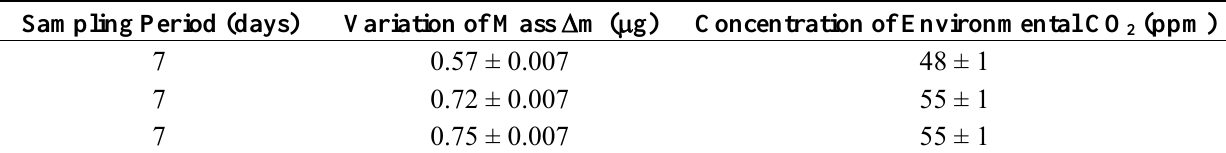
Table 1. Variation of mass in relation to the quantity of CO (indoor). The concentration of indoor CO concentration in the atmosphere, thus indicating good quality of the